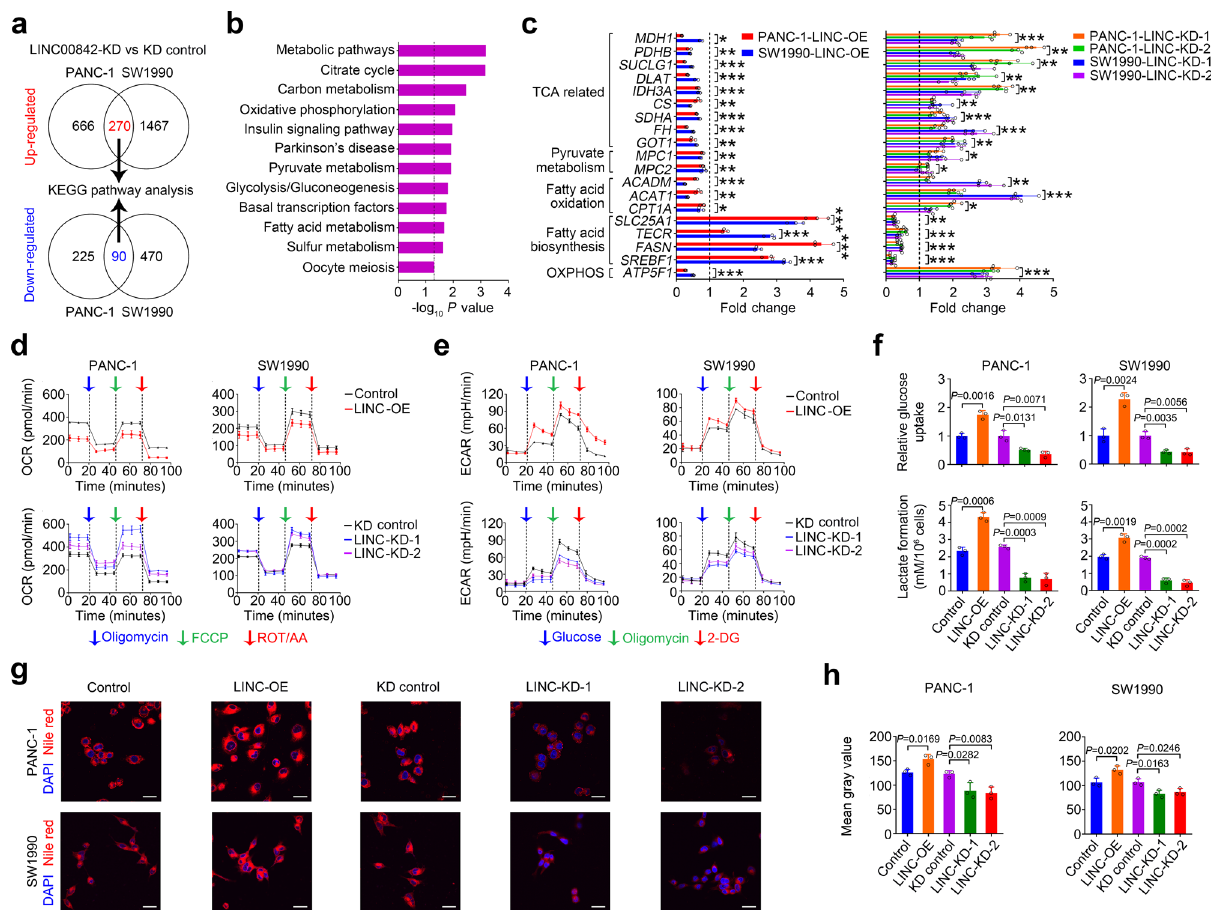
Fig. 2 LINC00842 alters metabolic programs in PDAC cells. a Differentially expressed genes identi fi ed by RNA sequencing in PDAC cells with or without LINC00842 knockdown (KD). Upregulated genes (fold change ≥ 2) and downregulated genes (fold change ≤ 0.5) were selected for pathway enrichment analysis. b Kyoto Encyclopedia of Genes and Genomes (KEGG) analysis of differentially expressed genes regulated by LINC00842 . The dotted line indicates P < 0.05 (two-tailed). c Validation of some RNA-sequencing results by using quantitative RT-PCR. Data were normalized to control or KD-control. TCA, tricarboxylic acid cycle; OXPHOS, oxidative phosphorylation. d , e Effects of LINC00842 overexpression (LINC-OE) or silence (LINC-KD) on oxygen consumption rate (OCR) ( d ) or extracellular acidi fi cation rate (ECAR) ( e ). f Effects of LINC00842 expression change on glucose uptake or lactate production. g , h Representative pictures of Nile red (red) and DAPI (blue) staining of cells with LINC00842 overexpression or silencing ( g ) and quanti fi cation using Image J software ( h ). Scale bar, 30 μ m. Results in ( c ), ( f ), and ( h ) are mean ± SD from 3 independent experiments. The P value in ( f ), ( h ) and * P < 0.05; ** P < 0.01, and *** P < 0.001 in ( c ) were determined by Student ’ s t -test